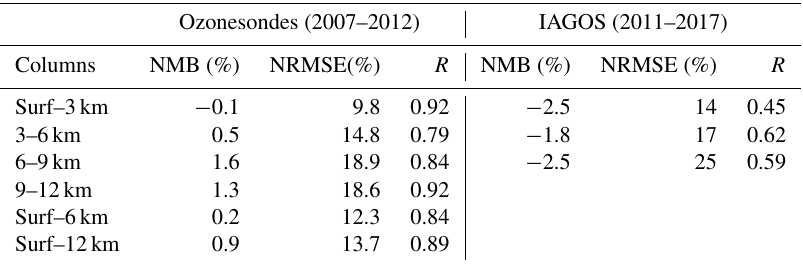
Table 1. Statistics of the comparison of different O 3 partial columns derived from IASI with O 3 partial columns measured with ozonesondes for 2007–2012 all the globe and with IAGOS for 2011–2017 for North China–Korean Peninsula. The normalised mean bias (NMB), the normalised root mean square error (NRMSE), and the Pearson correlation coefficient ( R ) are provided.